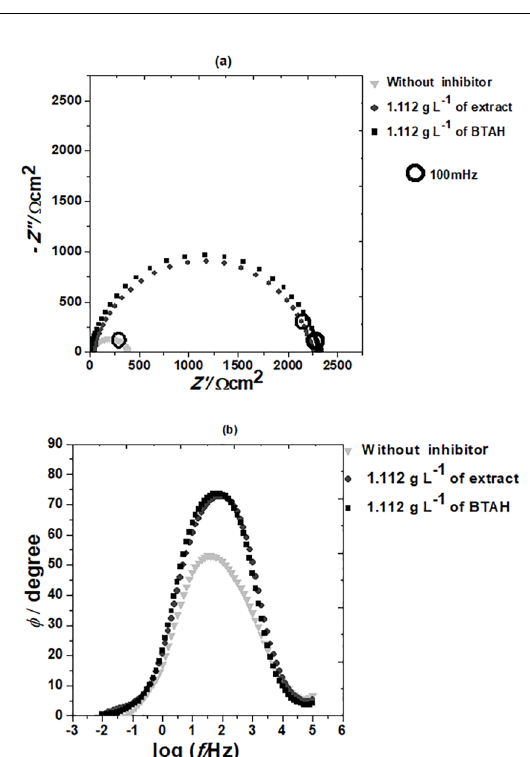
Figure 3. Nyquist (a) and Bode phase angle (b) plots for CS - ASTM 1020 after 90 min immersion in HCl 18.23 g L -1 in the absence and in the presence of different amounts of cocoa bark extract.